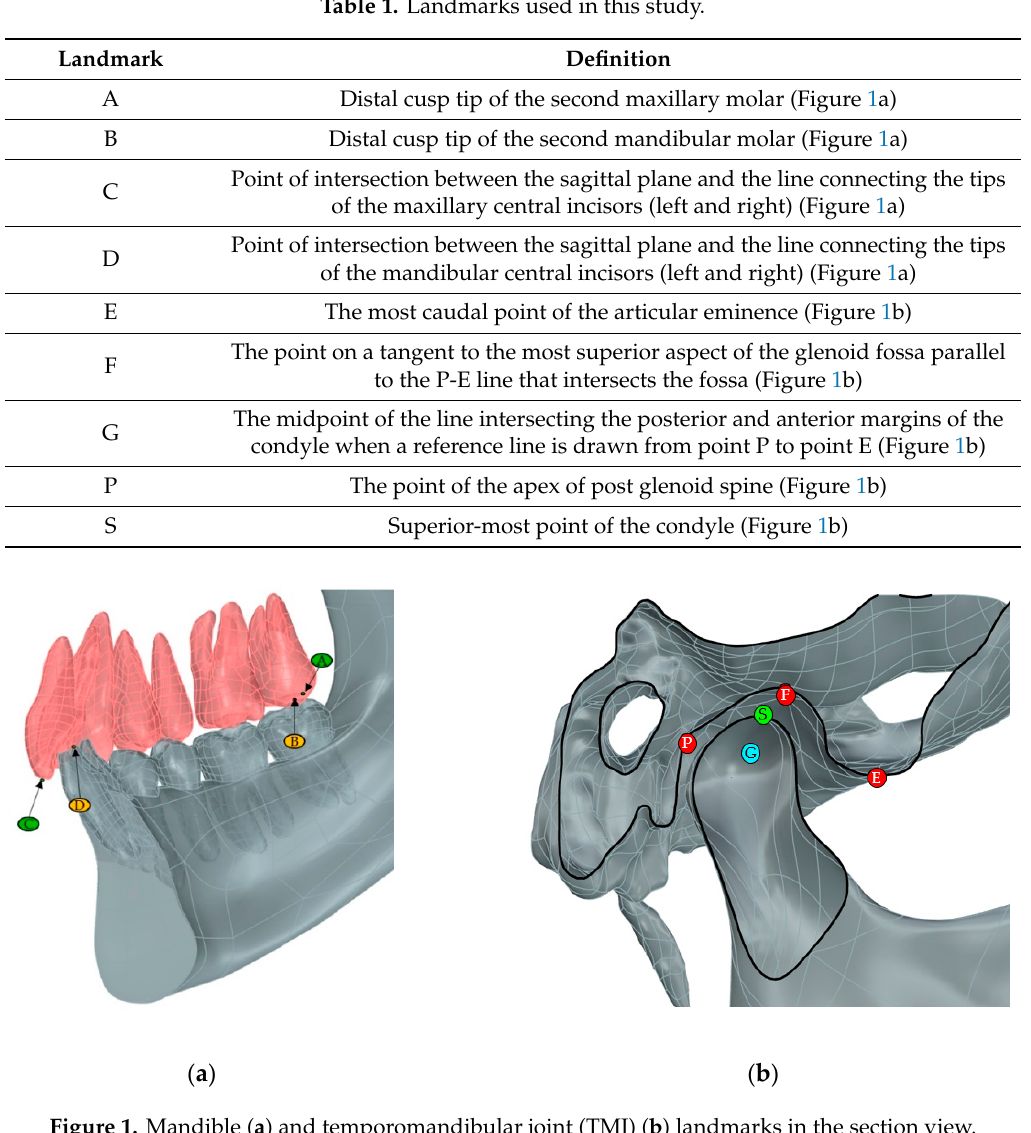
Figure 1. Mandible ( a ) and temporomandibular joint (TMJ) ( b ) landmarks in the section view.